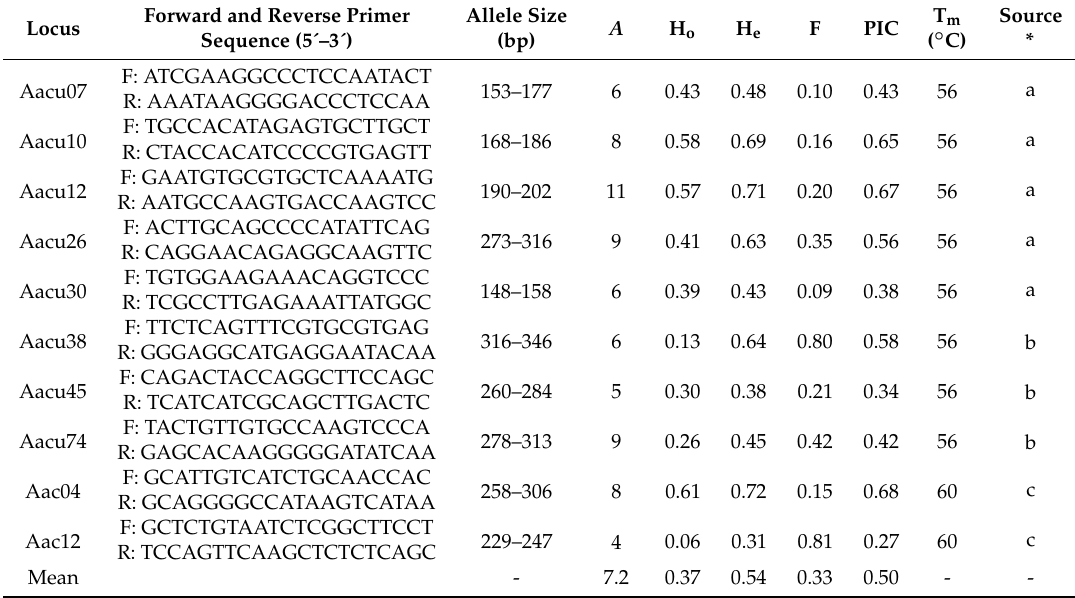
Table 2. Primer pairs of 10 SSR (Simple Sequence Repeats) markers used in the study along with average values obtained for different parameters per locus.